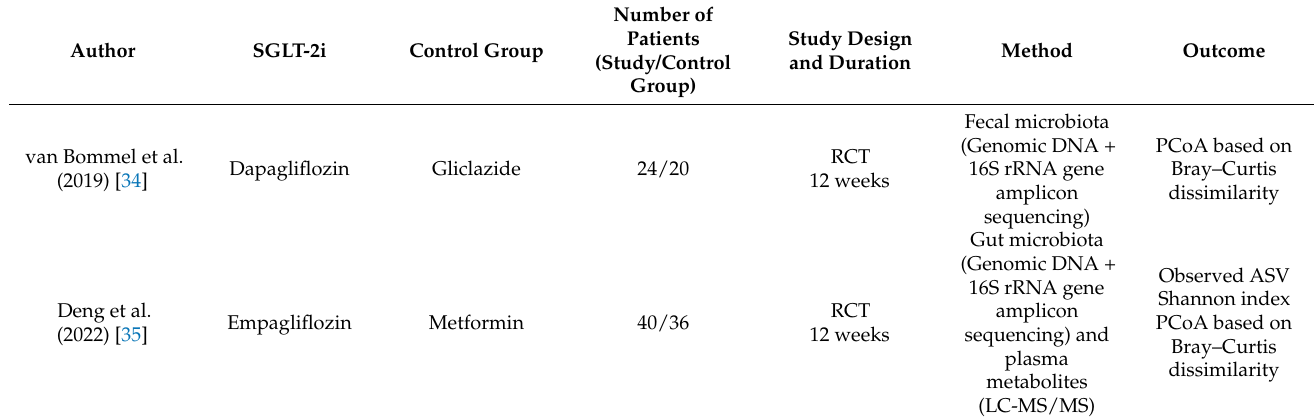
Table 1. SGLT-2i effect on microbiota in